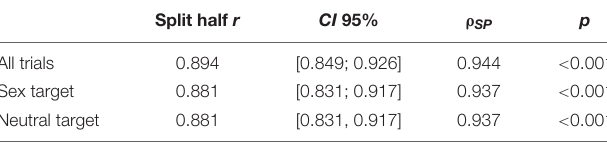
TABLE 2 | Dot-probe task: Split-half reliability estimates.